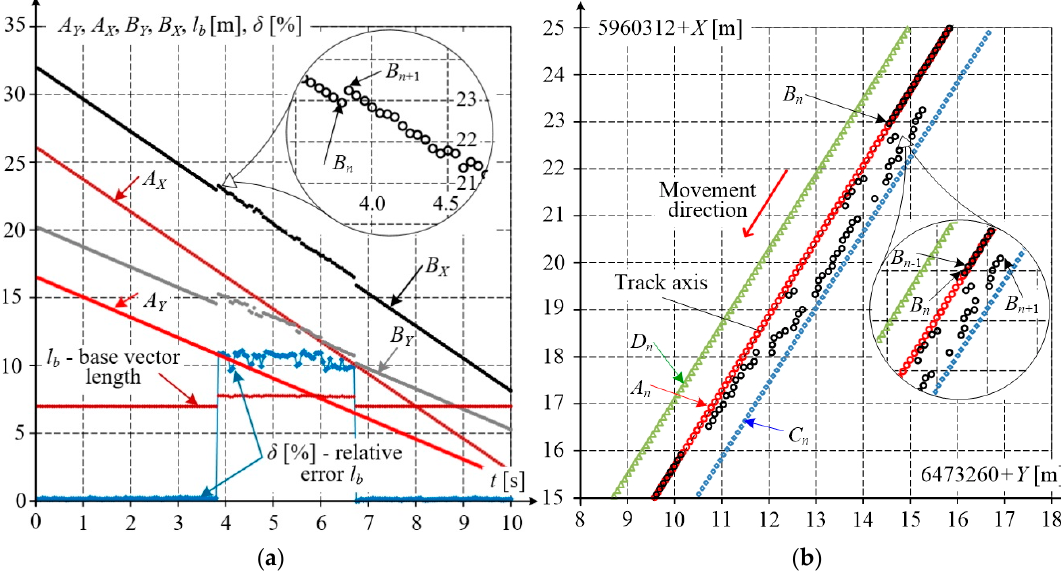
Figure 9. Example of incorrect dataset: ( a ) waveforms of correct and incorrect results acquired by receivers A and B , complemented by the calculated base length l b and its relative error δ ; ( b ) correct results acquired by receivers A , C and D , and incorrect results acquired by receiver B .